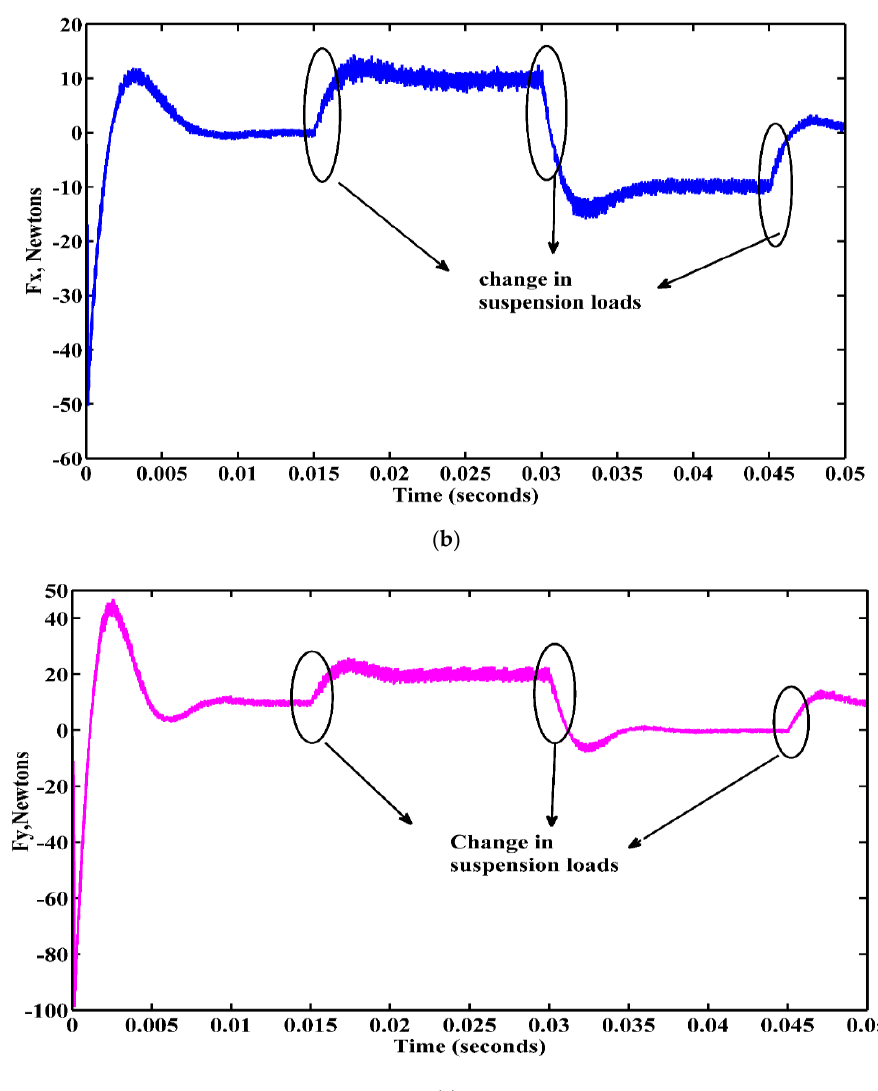
Figure 16. Fourth quadrant Suspension parameters. ( a ) Rotor Xand Y-axis dispalcements when suspension loads are applied; ( b ) Suspension force in the X direction when suspension loads are applied; ( c ) suspension force in the X direction when suspension loads are applied.